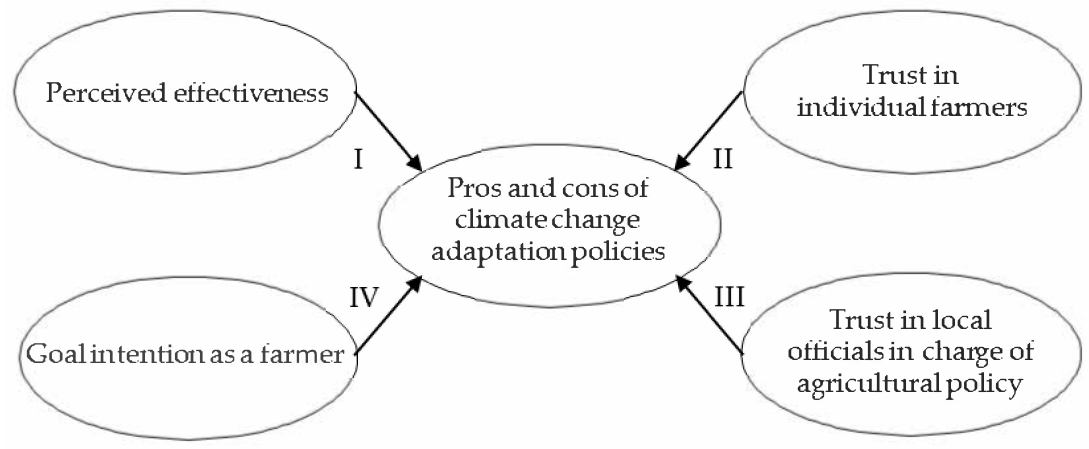
Figure 1. Determinants to pros and cons of climate change adaptation